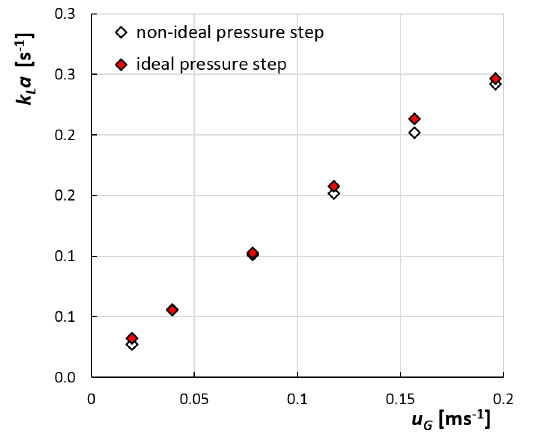
Figure 5. Effect of pressure step non-ideality on k L a values. All the data were evaluated with measured real pressure profile.